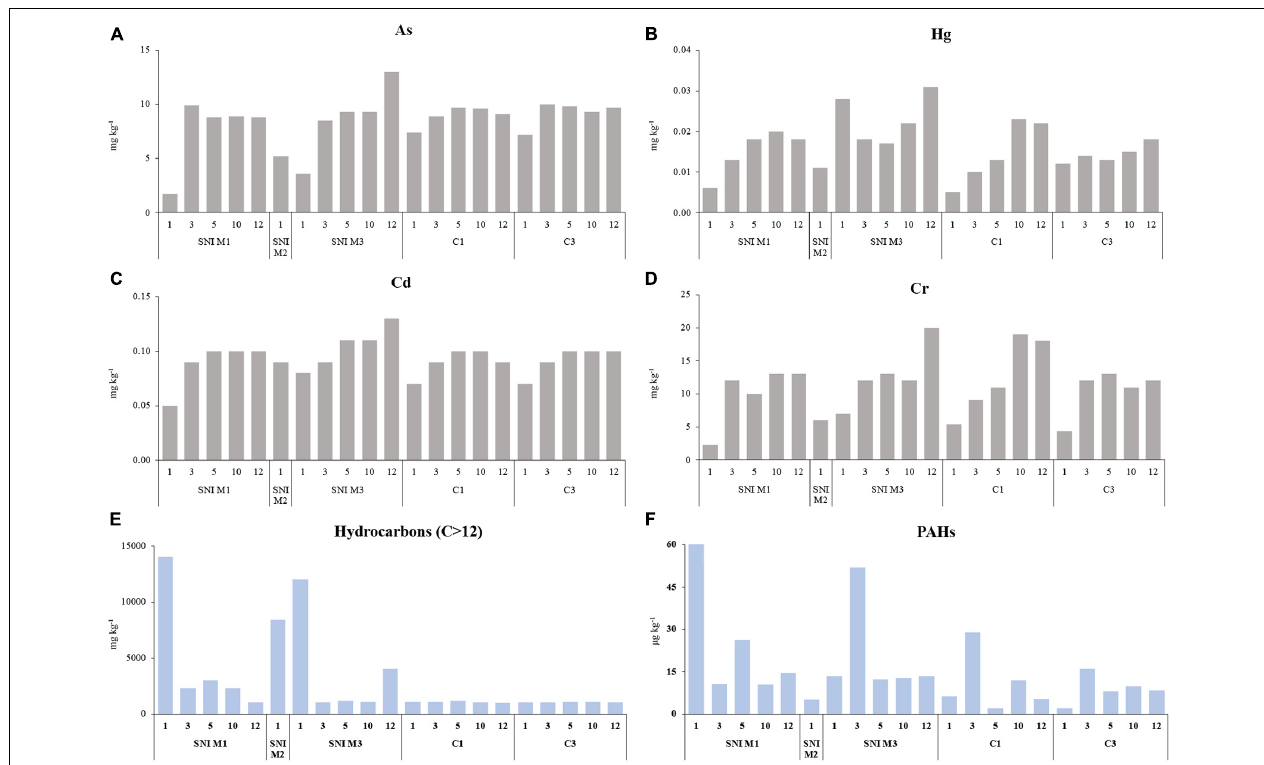
FIGURE 2 | Bathymetric distribution of the contaminant concentrations in the sediments of the SNI (M1, M2, and M3) and control (C1, C2, and C3) transects. (A) Arsenic (As, mg kg − 1 ), (B) Mercury (Hg, mg kg − 1 ), (C) Cadmium (Cd, mg kg − 1 ), (D) Chrome (Cr, mg kg − 1 ), (E) Hydrocarbons C > 12 (mg kg − 1 ), and (F) Polycyclic Aromatic Hydrocarbons (PAHs) concentrations (mg kg − 1